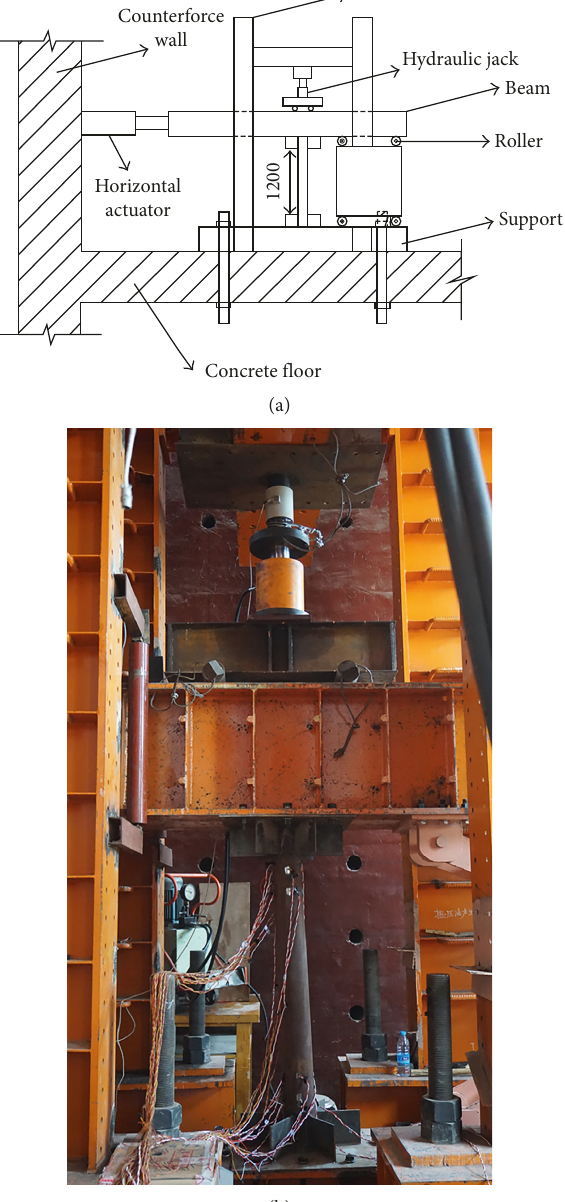
Figure 2: Loading device for specimen. (a) Sketch of sample loading device and (b) sample loading device spot map.